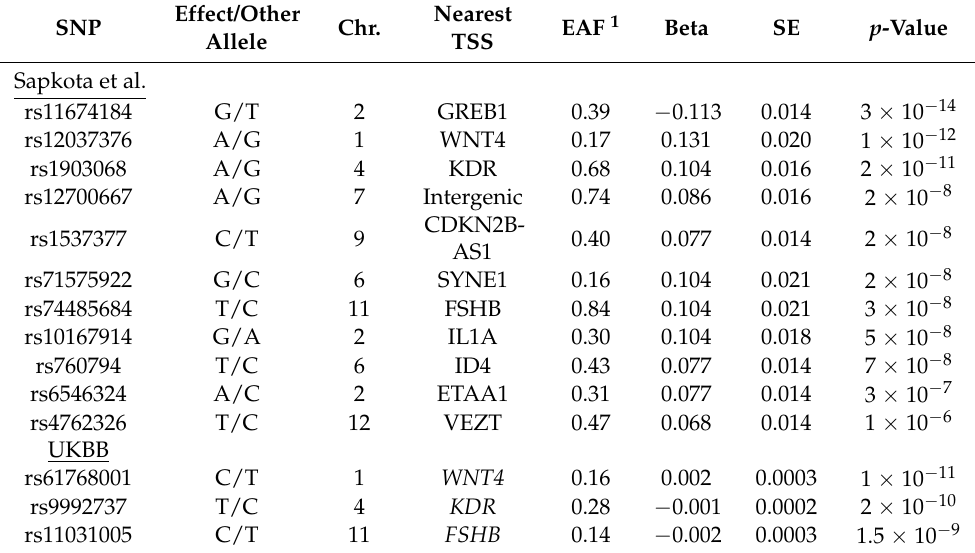
Table 4. Summary information on endometriosis SNPs used as genetic instruments for the 2SMR analysis. SNP: single nucleotide polymorphism; Chr.: chromosome; TSS: transcription start site; EAF: effect allele frequency; SE: standard error. SNPs are ordered based on ascending p